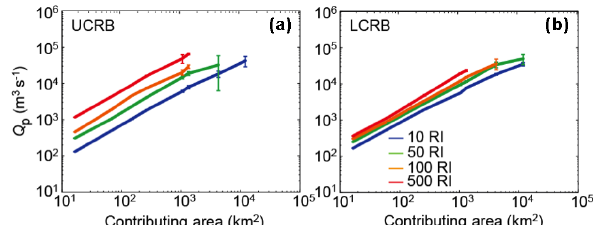
Figure 6. Frequency–magnitude–area (FMA) curves of Q p vs. con- tributing area for recurrence intervals (RIs) of 10, 50, 100, and 500 years for the Upper Colorado River Basin (UCRB; a ) and the Lower Colorado River Basin (LCRB; b